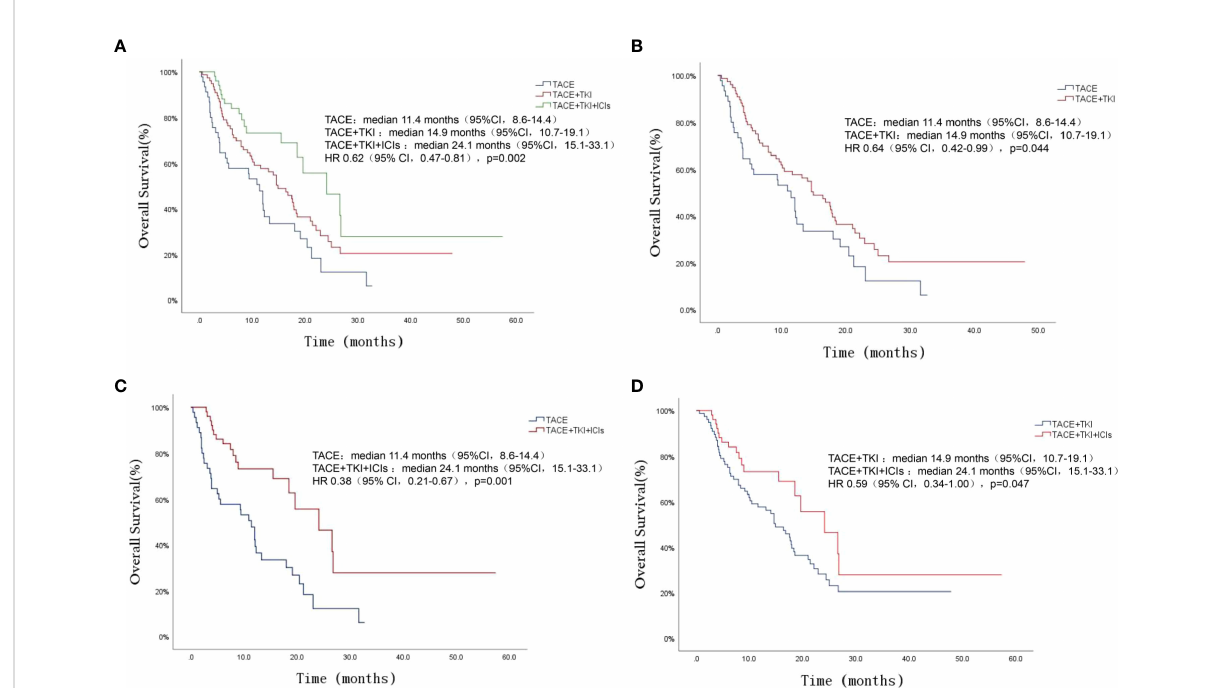
FIGURE 1 Kaplan-Meier survival curves showing OS strati fi ed by treatment options in patients of uHCC. Comparison of OS among the three groups of patients (A) . OS comparison between TACE group and TACE+TKI group (B) . OS comparison between TACE group and TACE+TKI+ICIs group (C) . OS comparison between TACE+TKI group and TACE+TKI+ICIs group (D) .